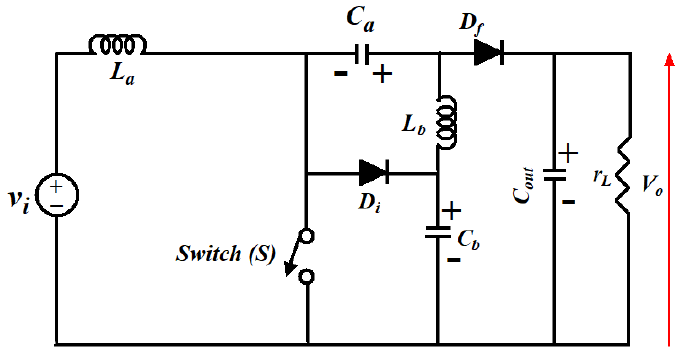
Figure 6. Circuit layout of MSEPIC converter.